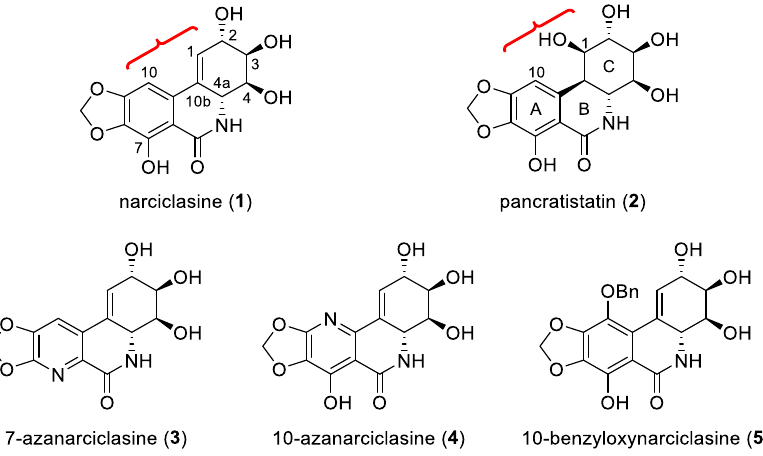
Figure 1. Major Amaryllidaceae constituents and unnatural derivatives of narciclasine.